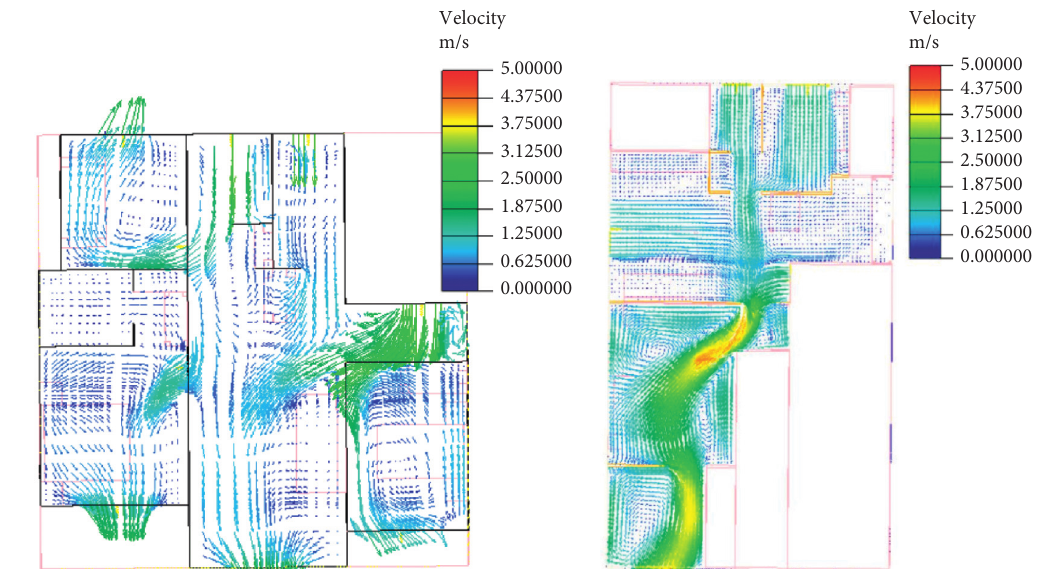
Figure 5: Velocity vector distribution of two house types A and B under condition 1.